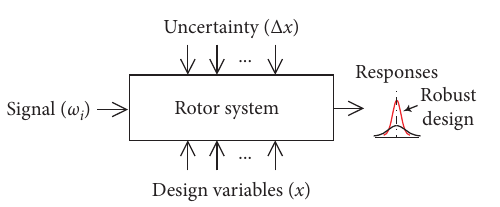
Figure 9: P-diagram for the rotor